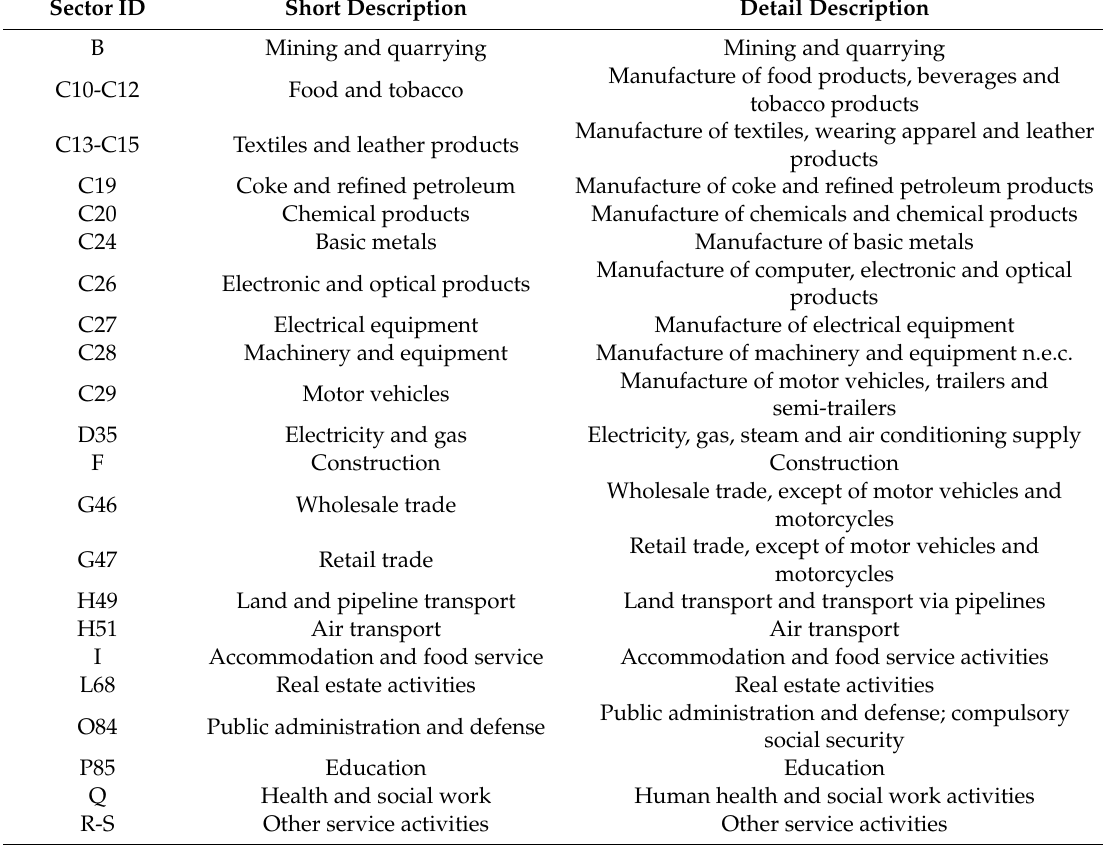
Table A3. 22 key sectors in G20 countries.